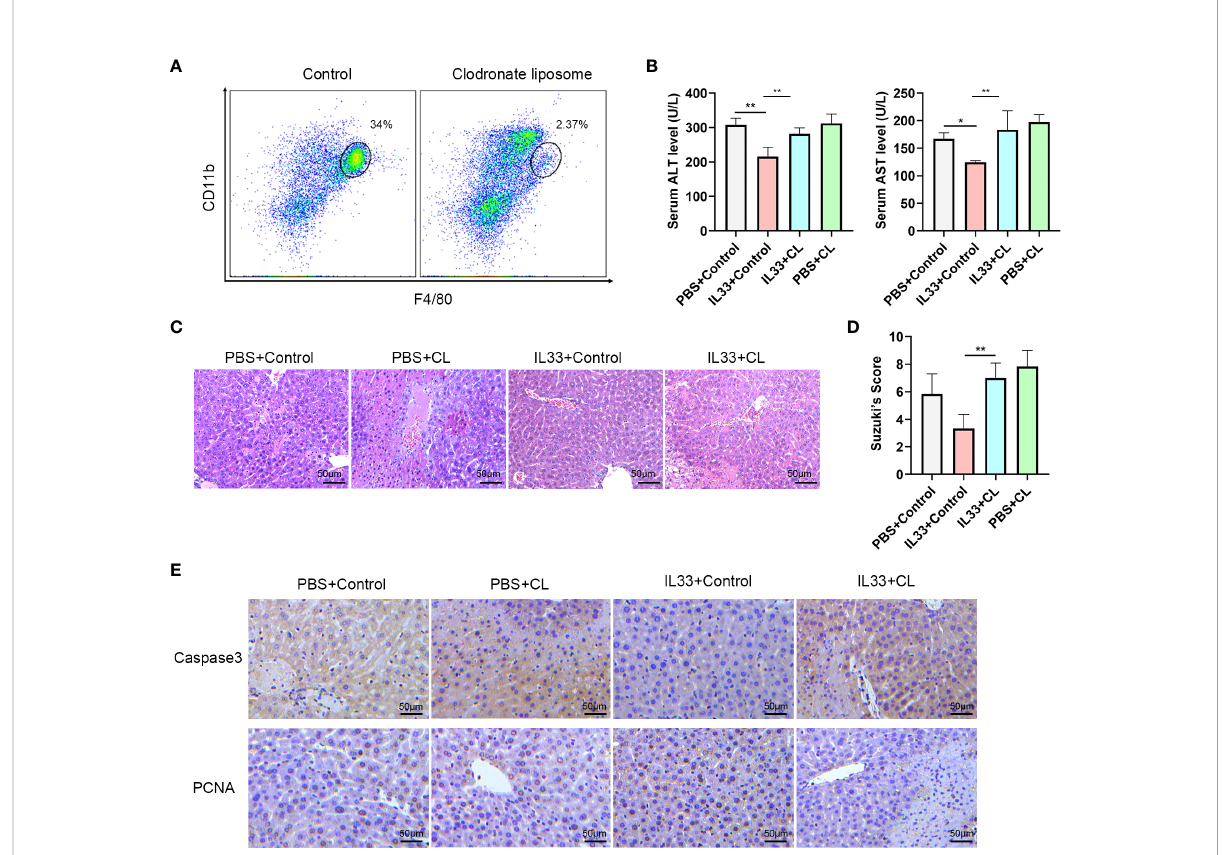
FIGURE 4 Macrophages depletion prevents protective effects of exogenous IL-33 on hepatic IRI (A) Representative FACS analysis showing depletion of macrophages following administration of Clodronate Liposomes (CL). (B) Serum ALT and AST levels of mice in PBS+control, PBS+CL, IL33+control and IL33+CL groups 12 h after IRI. (C) Histopathological changes in livers within the different treatment groups 12 h after IRI. (D) Suzuki ’ s Scores quantifying the capacity for CL to attenuate the protective effects of exogenous IL-33 against hepatic IRI (n=6 per group) (mice were Euthanized 12h after IRI). (E) Histochemistry of caspase3 and PCNA in the four groups (mice were euthanized 12h after IRI). (* P <0.05, ** P